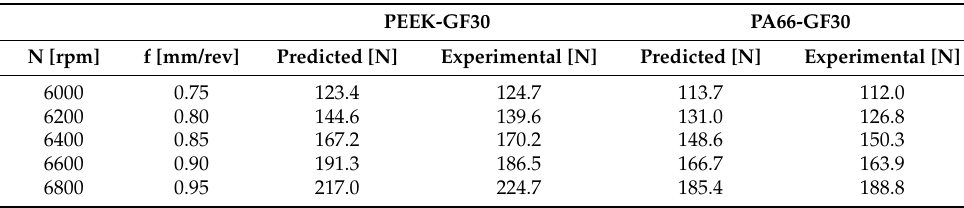
Table 8. Validation of results for thrust forces,